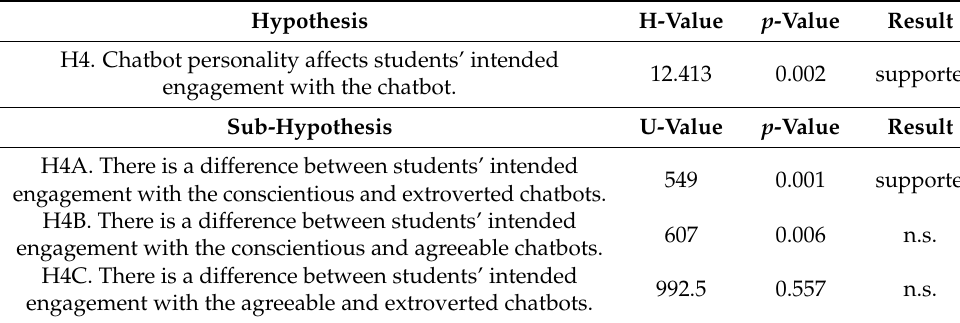
Table 6. Hypothesis 4 Testing Results.